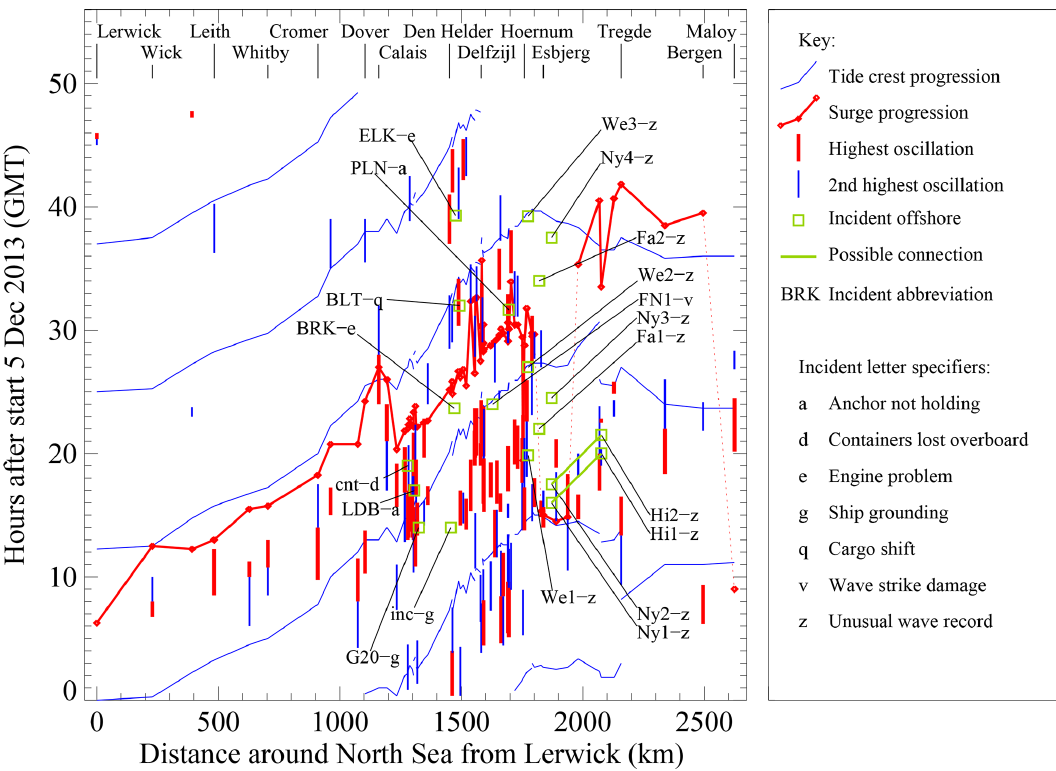
Figure 7. Summary of the progression of the tidal crests and storm surge peak around the North Sea on 5–6 December 2013, and spatial- temporal relationship of the highest short period oscillations in the tide gauge record and maritime incidents/accidents. The data are plotted on axes of time versus counter-clockwise distance around the North Sea starting from Lerwick. (These data are separated and plotted as simplified diagrams in Figs. S11 and